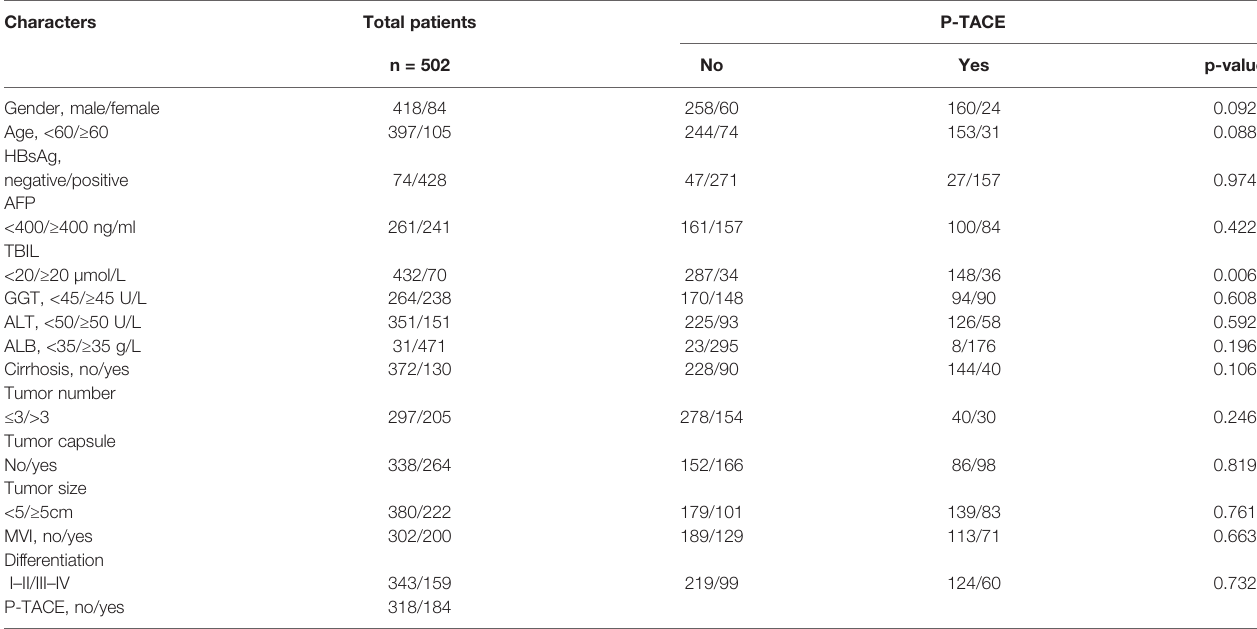
TABLE 1 | Demographic and clinical characteristics of